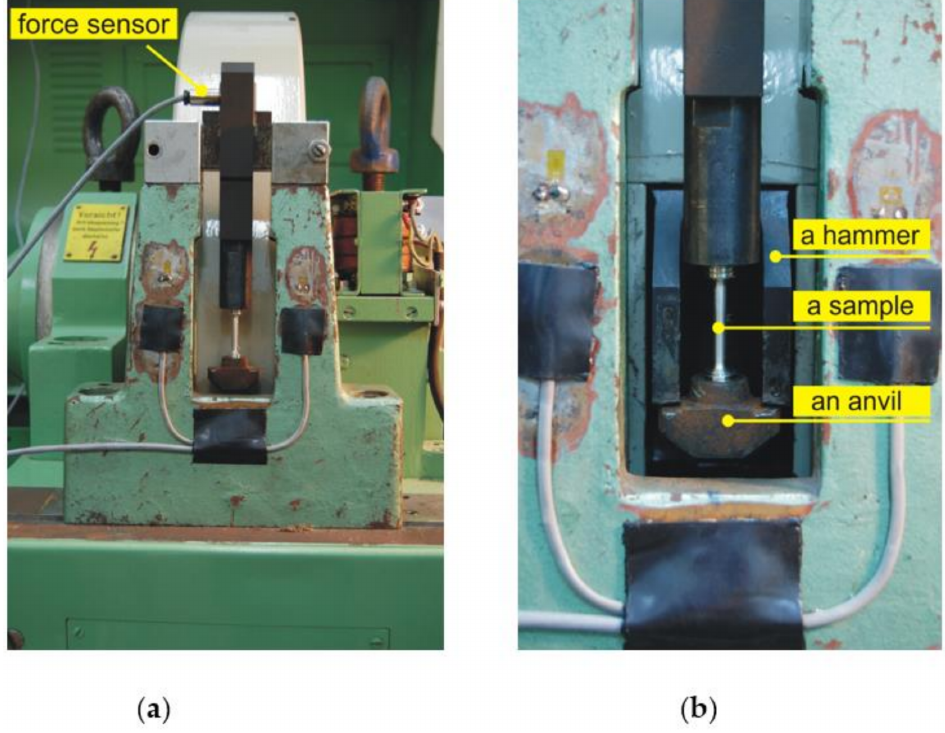
Figure 3. Rotating hammer working space in dynamic tensile test with a tensiometric sensor in the upper handle ( a ); sample with an anvil mounted at the bottom ( b